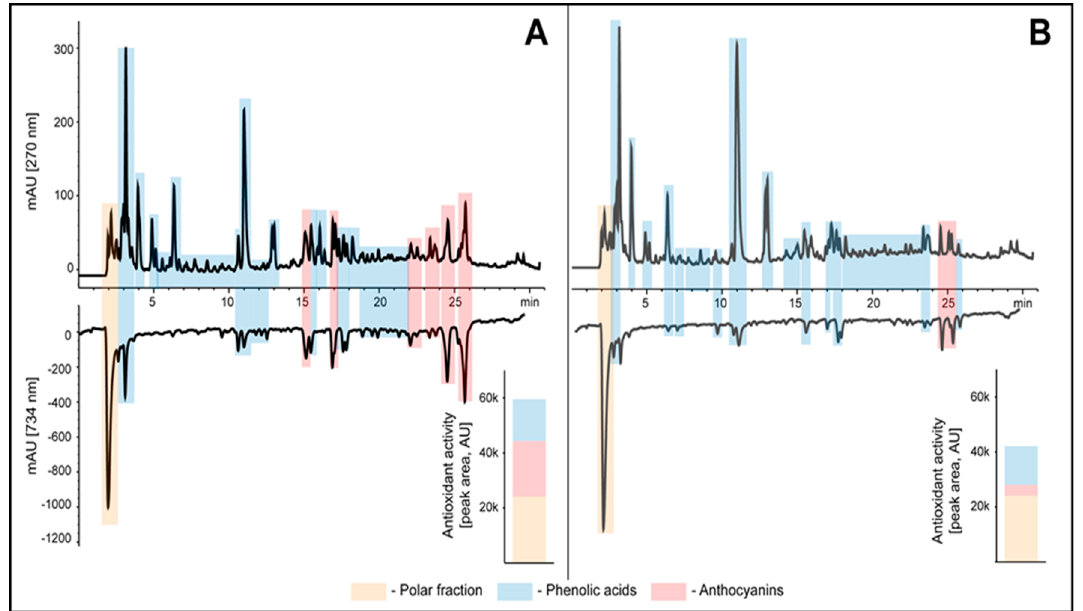
Figure 3. Sample HPLC chromatogram of extracts from red cabbage young shoots ( A ) and white cabbage young shoots ( B ) (top chromatograms at 270 nm) along with profiles of antioxidants detected online with ABTS reagent (bottom chro- matograms at 734 nm). The groups of phytochemicals were identified on the basis of UV-Vis spectra. The antioxidant activity of samples was assessed as a sum of area under the negative peaks of identified group of phytochemicals recorded during post-column derivatisation with ABTS reagent and presented as a bar graphs.